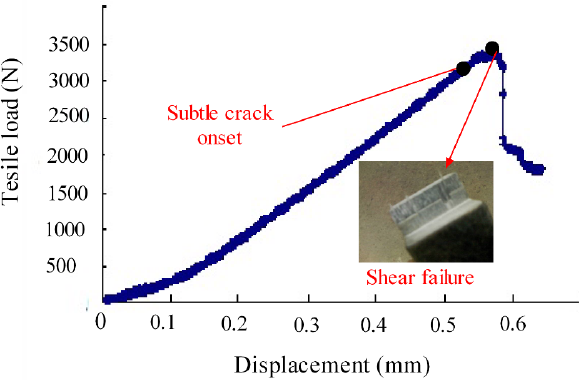
Figure 8: Load-displacement curve with an external normal stress of 11.3 MPa